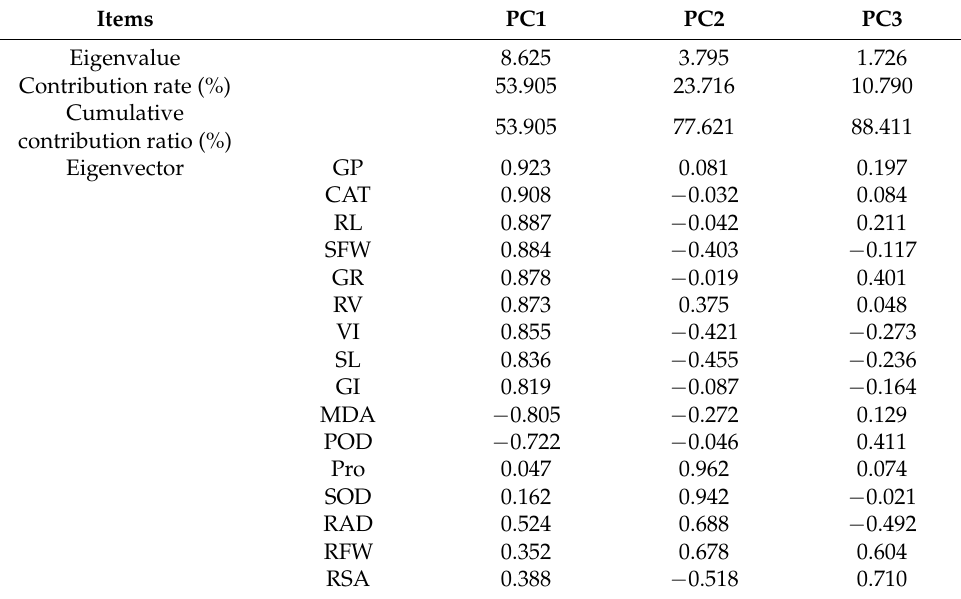
Figure 6. Correlation matrix between all indices. GP, germination potential; GR, germination rate; GI, germination index; VI, vigor index; SL, shoot length; SFW, shoot fresh weight; RL, root length; RSA, root surface area; RAD, root average diameter; RV, root volume; RFW, root fresh weight; CAT, catalase; SOD, superoxide dismutase; POD, peroxidase; MDA, malondialdehyde; Pro, proline. Numbers represent the Pearson correlation statistics. ** denotes significance at p < 0.01; * denotes significance at p < 0.05. Table 3. Eigenvalues, contribution rates, and eigenvectors for each principal